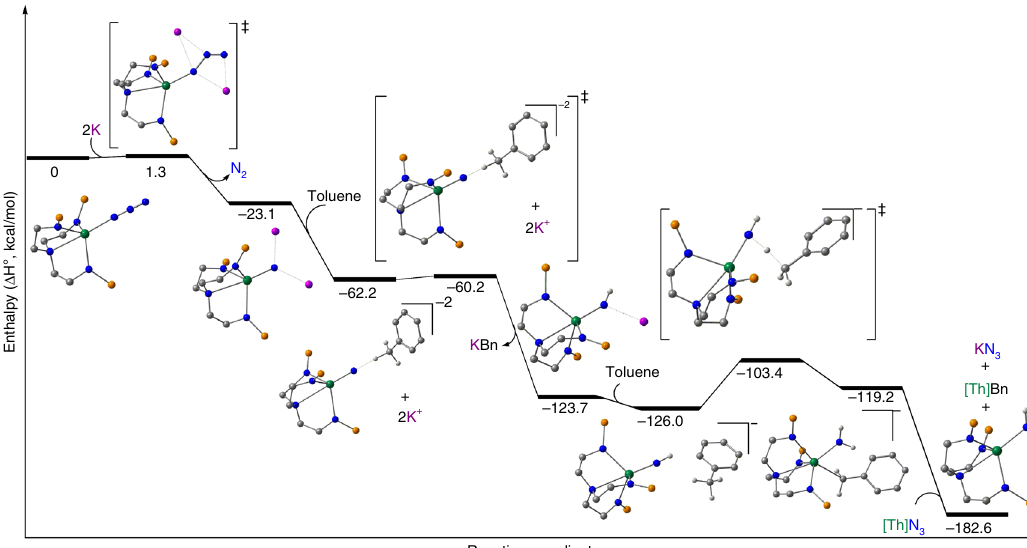
Fig. 3 Computed reaction pro fi le for the reduction of 2 by potassium in toluene. This pathway accounts for the reduction of the azide to nitride then subsequent protonation from toluene solvent to give a parent imido which reacts further with toluene to give parent amide 5 along with benzyl 3 and potassium-azide in-line with experimental fi ndings. The iso-propyl groups of the silyl substituents are omitted for clarity. In this reaction scheme potassium rather than potassium graphite was used to give a tractable calculation